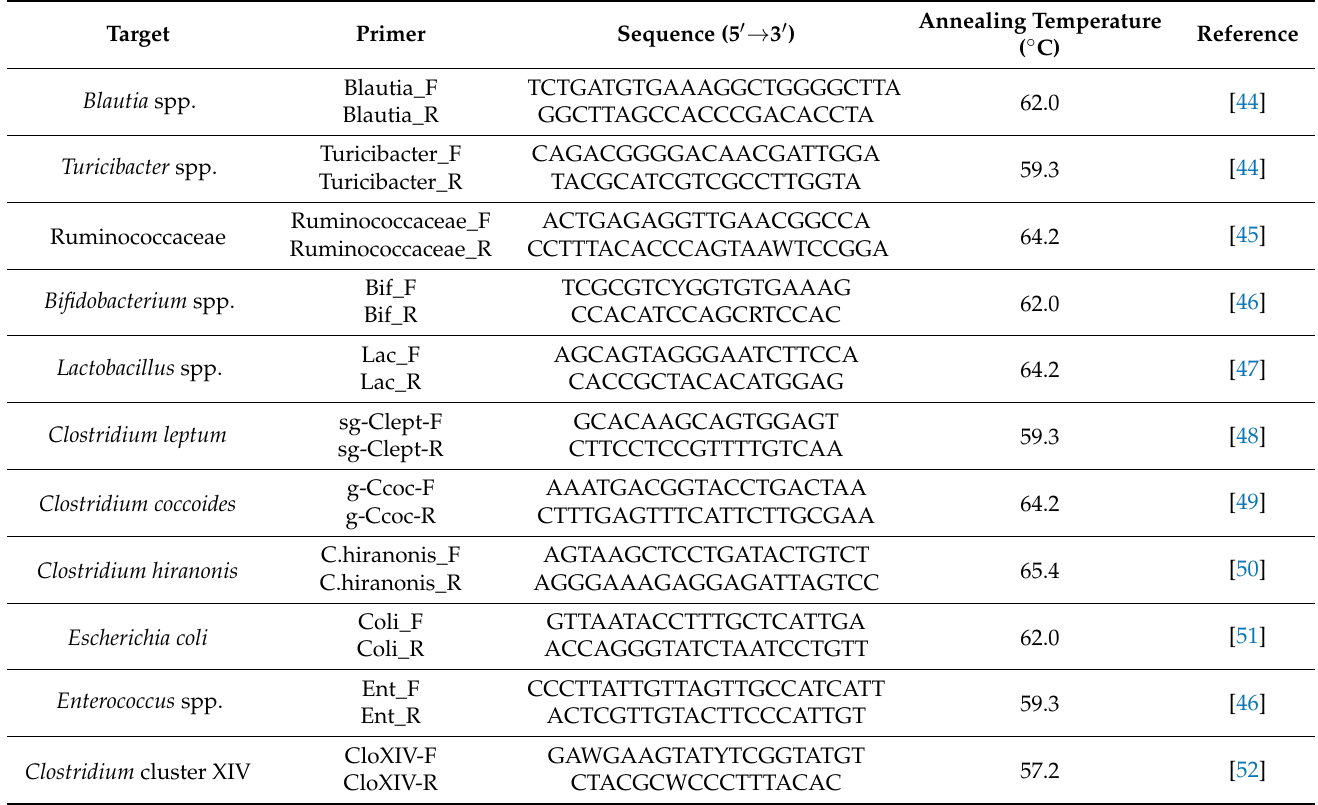
Table 3. Primers used in the qPCR